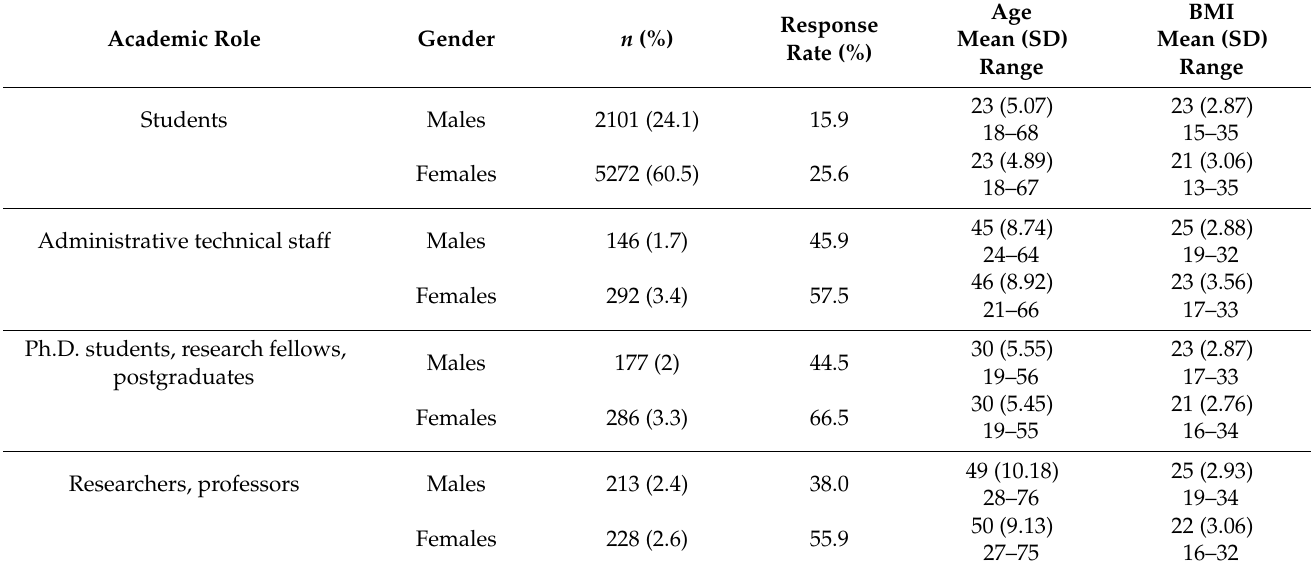
Table 1. Sociodemographic characteristics of the sample ( n =